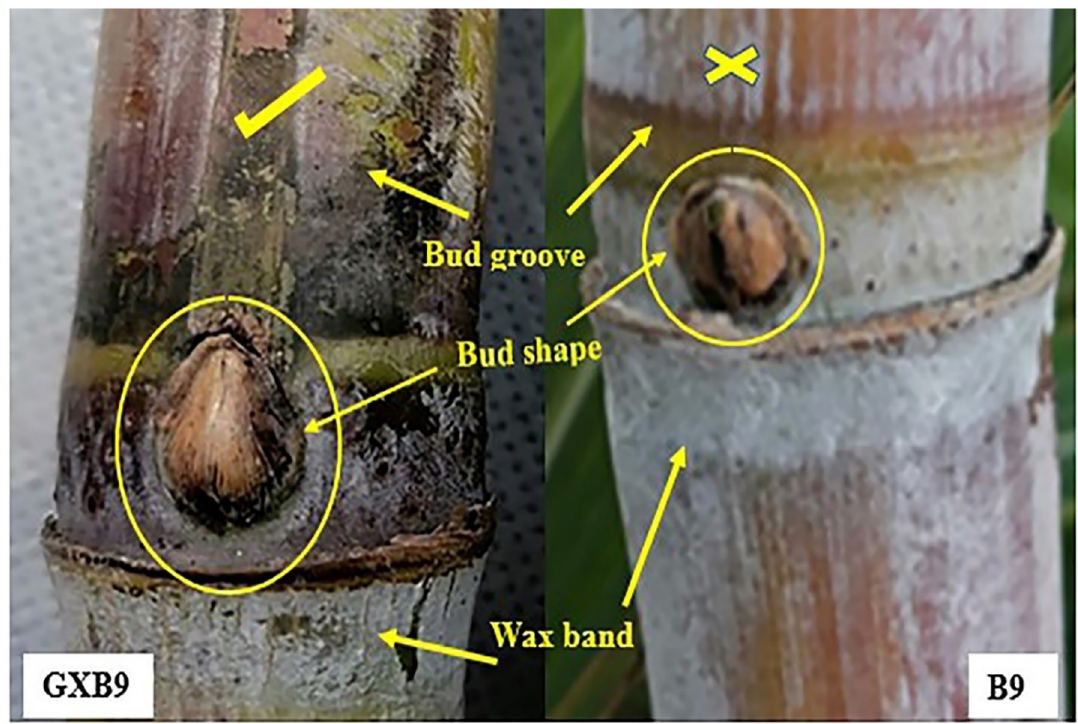
Fig 7. Comparison of bud characteristics between GXB9 and B9 at mature stage.